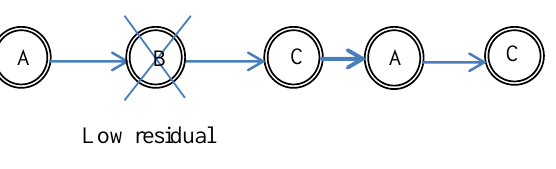
Figure 8. An example of applying the mutation operator